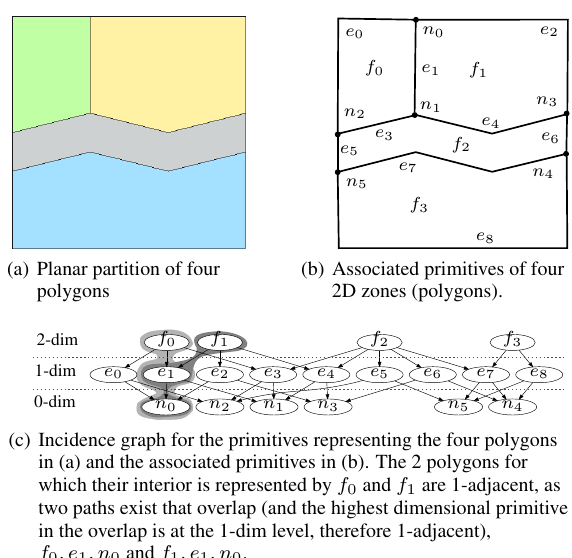
Figure 3: Incidence and adjacency can be defined by drawing a graph of how the composing primitives for zones are